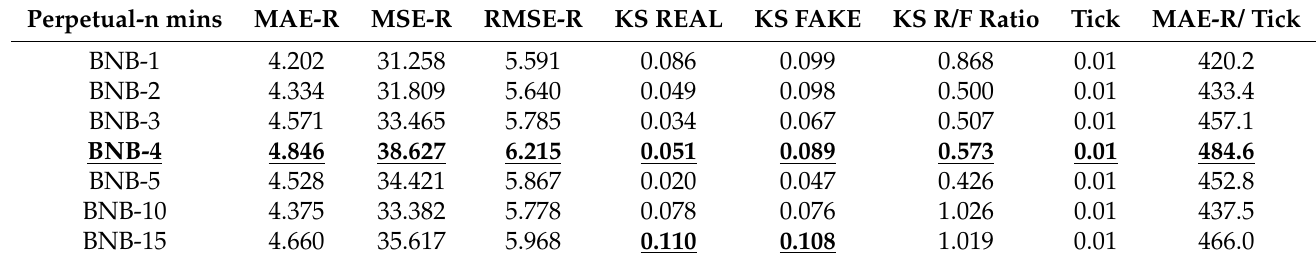
Table 18. We compared BNBUSDT perpetual futures at multiple intervals. Interestingly, BNB, ETH, BTC, ADA and XRP perpetual futures all show the highest KS FAKE score in 15 min intervals due to high